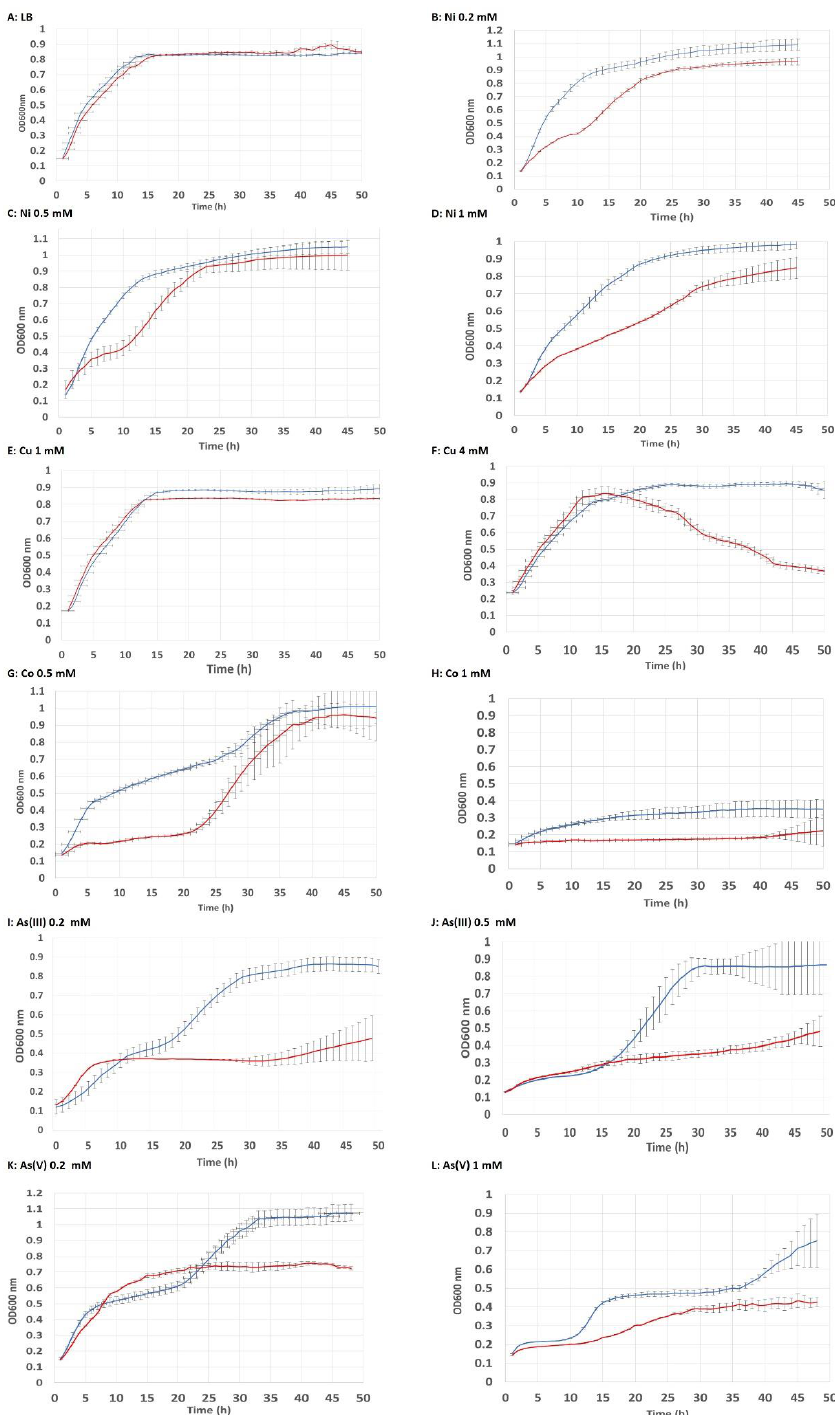
Figure 2. Growth curves of Escherichia coli in LB-MOPS broth supplemented with 100 µ g mL − 1 ampicillin (Ap). The optical density at 600 nm (OD 600 ) was measured every hour for each strain for 50 cycles (49 h). NC: E. coli negative control (red line). CaPCS2: E. coli cells carrying the pdr11 plasmid with the CaPCS2 gene (blue line). ( A ): control not treated (LB). ( B ): NiCl 2 0.2 mM. ( C ): NiCl 2 0.5 mM. ( D ): NiCl 2 1 mM. ( E ): CuSO 4 · 5 H 2 O 1 mM. ( F ): CuSO 4 · 5 H 2 O 4 mM. ( G ): CoSO 4 · 7 H 2 O 0.5 mM. ( H ): CoSO 4 · 7 H 2 O 1 mM. ( I ): NaAsO 2 0.2 mM. J: NaAsO 2 0.5 mM. K: Na 2 HAsO 4 · 7 H 2 O 0.2 mM. ( L ): Na 2 HAsO 4 · 7 H 2 O 1 mM. The graphs show the mean of the seven different clones tested for each strain (NC and